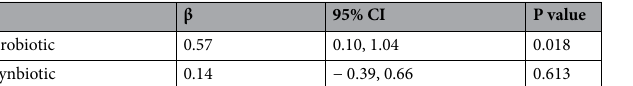
Table 5. Linear mixed-effects models to identify the longitudinal effects of probiotic or synbiotic on WAZ (from the first week following enrollment to study completion). Placebo is the reference group. Adjusted for age on 1st week, sex, WAZ on 1 st